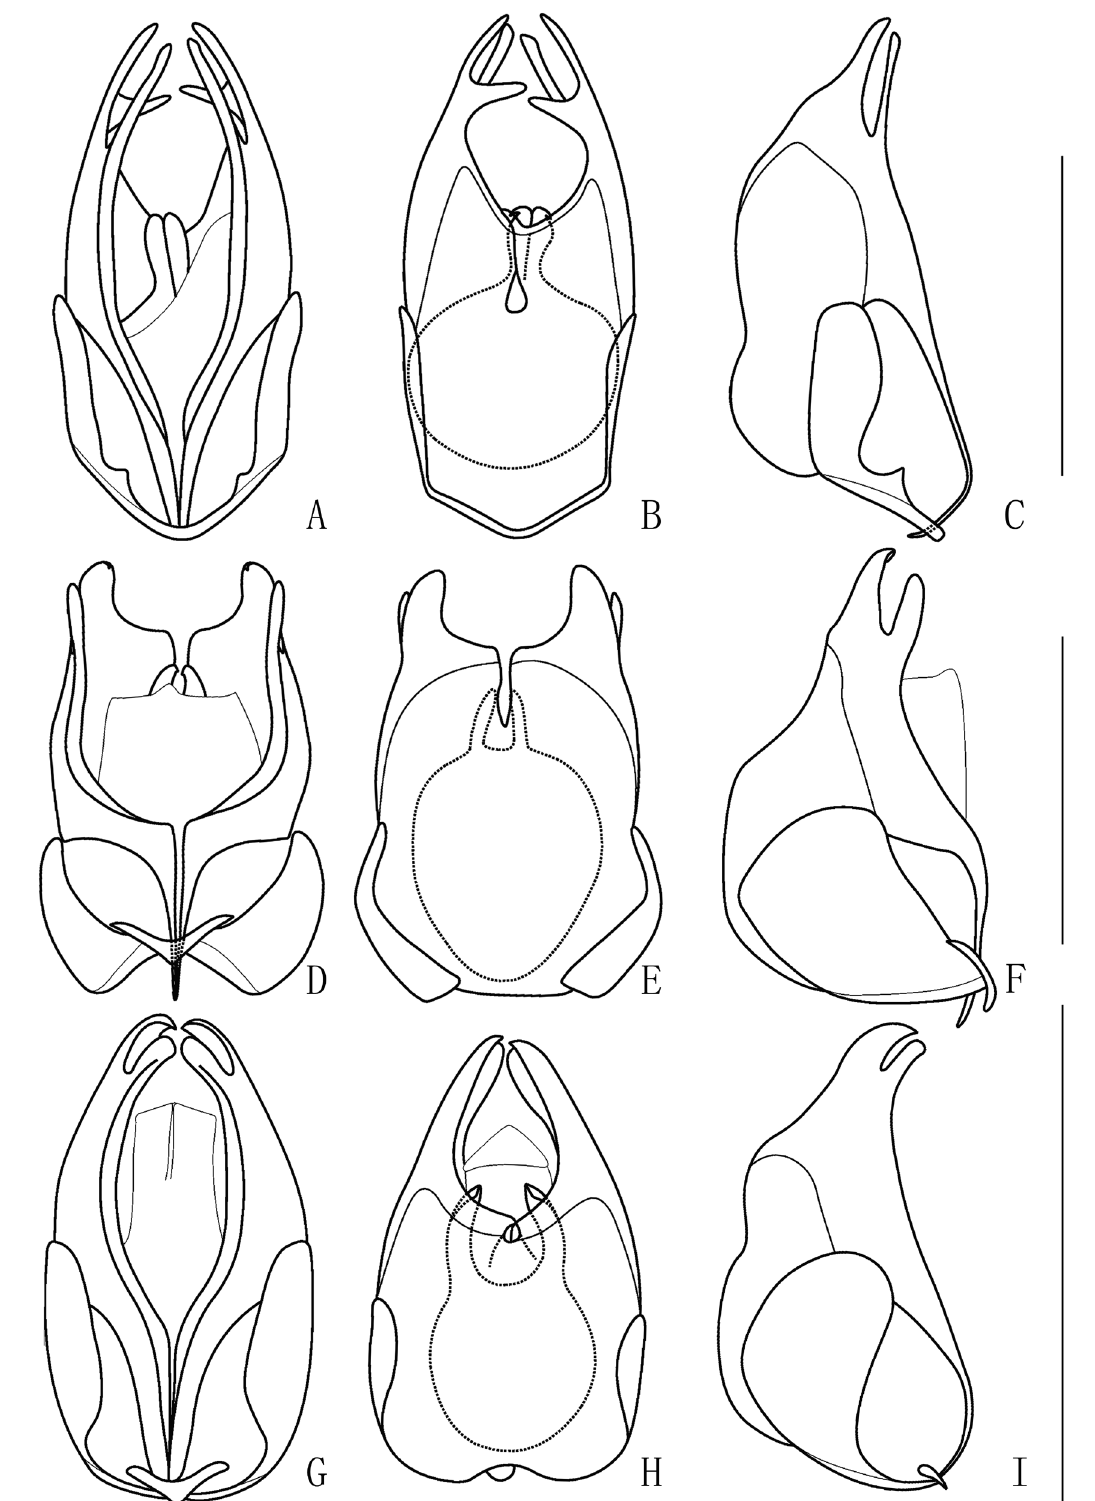
Fig. 4. Aedeagus (A, D, G = ventral view; B, E, H = dorsal view; C, F, I = lateral view). A‒C . Stenothemus nigriceps (Wittmer, 1955) comb. nov. (MHBU). D‒F . S. flavus Y. Yang & X. Yang sp. nov. (IZAS, IOZ(E)1123159). G‒I . S. longicornis Y. Yang & H. Liu sp. nov. (MHBU, HBU(E)410001). Scale bars: 1.0